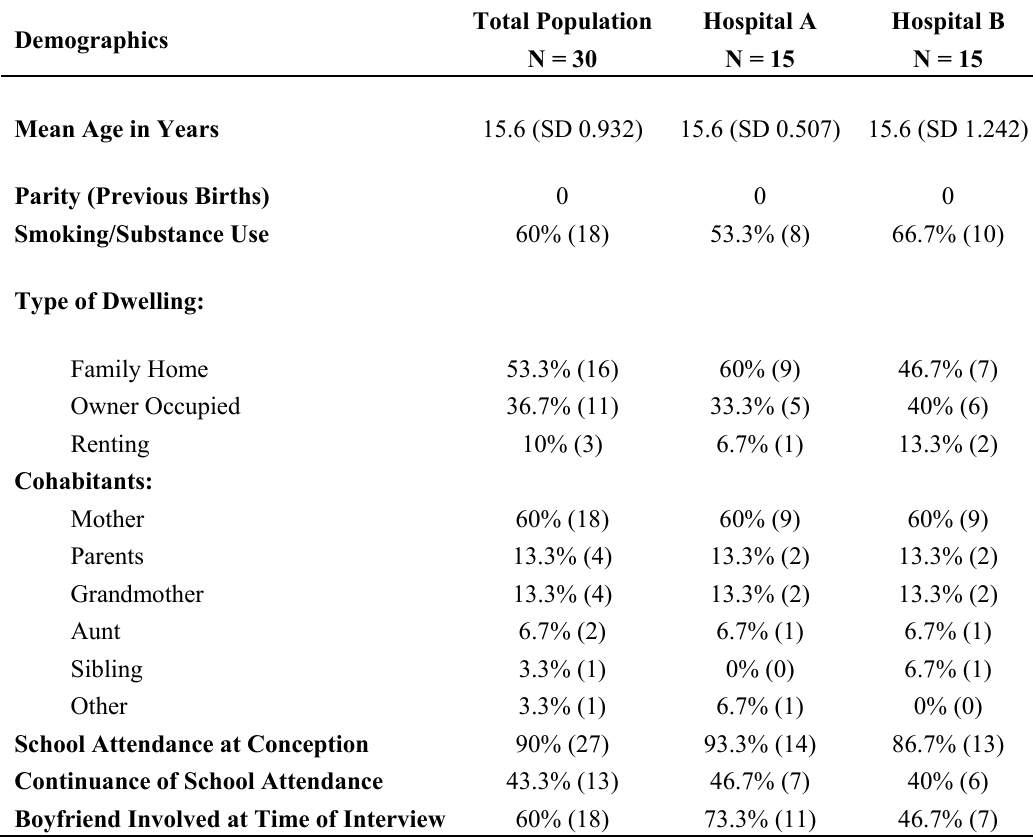
Table 1. Demographic characteristics of the pregnant